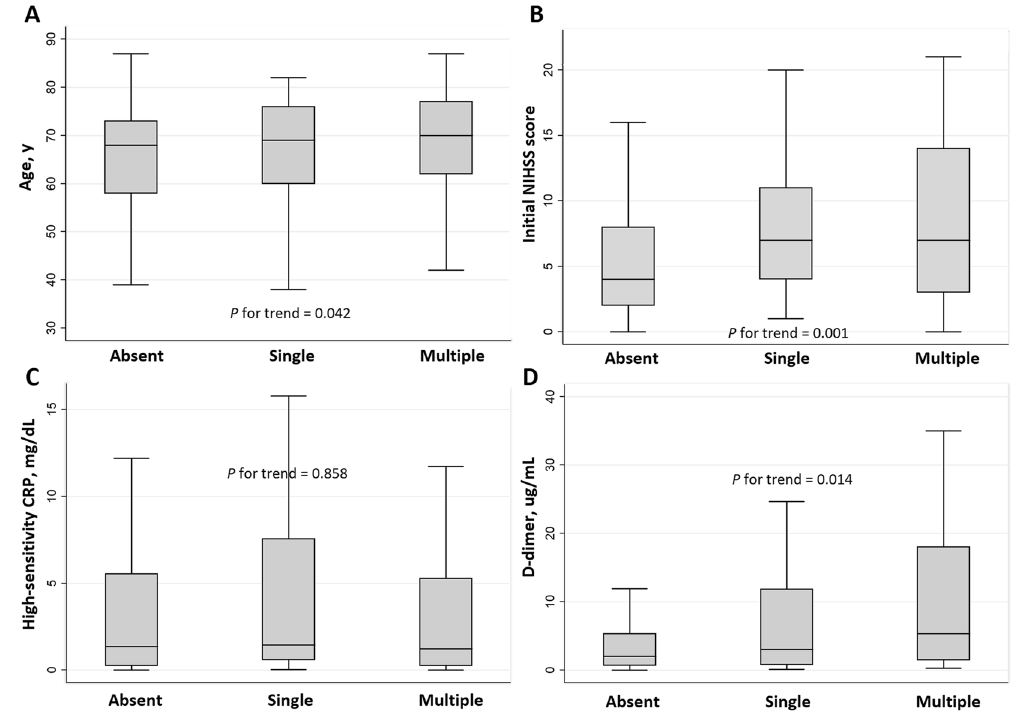
Figure 1. Comparisons of characteristics according to the silent brain infarct burden. Patients with multiple silent brain infarct (SBI) lesions were older ( P for trend = 0.042), showed higher initial NIHSS score ( P for trend = 0.001) and D-dimer levels ( P for trend = 0.014) than those with an no lesion or a single lesion. The SBI burden showed no statistically significant correlation with high-sensitivity C-reactive protein